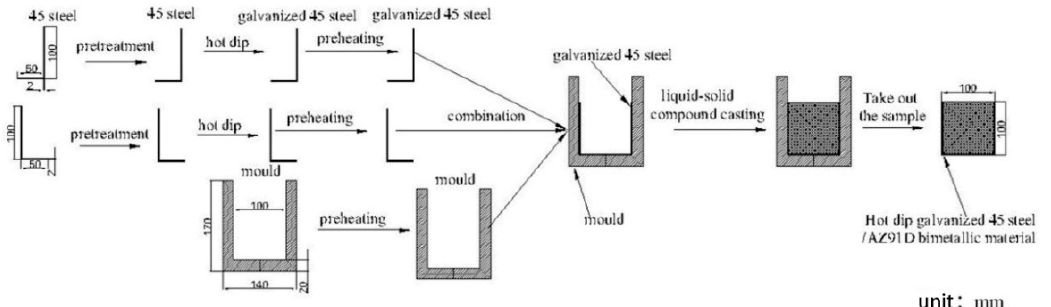
Figure 1. Schematic diagram of outer cladding by solid–liquid compound casting.